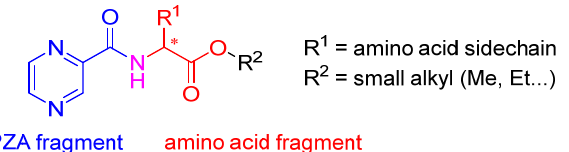
Figure 1. General structure of the proposed compounds. Asterisk symbol (*) denotes position of the stereo center.